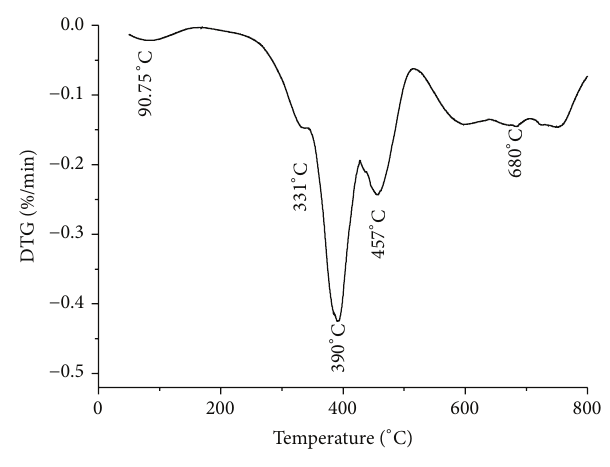
Figure 5: DTGA of sample 10.